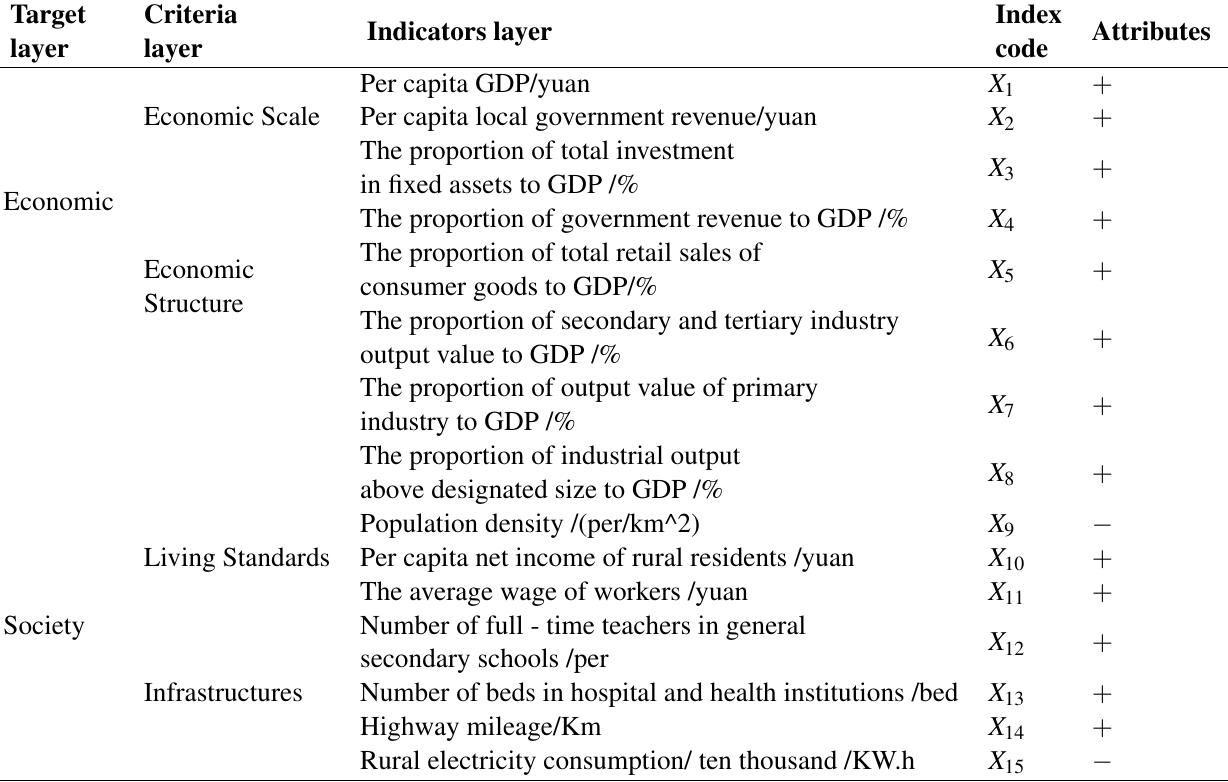
Table 1 A comprehensive system for evaluating county-level social and economic